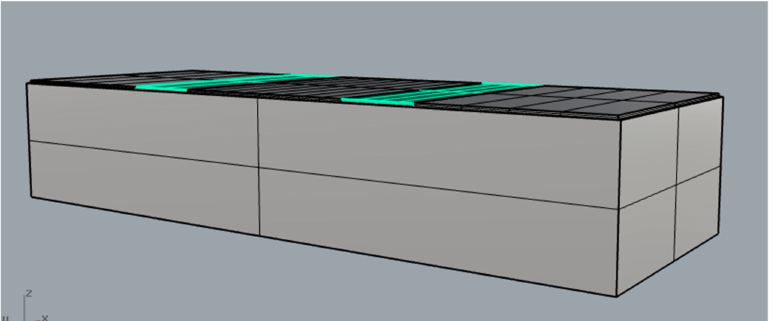
Figure 6. Skylight opening typical